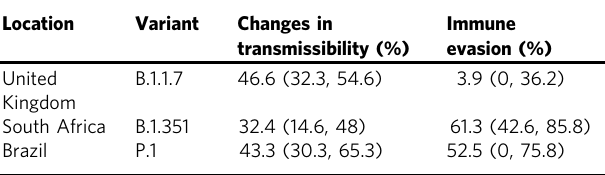
Numbers show model-estimated mean (95% CI) from 100 model-inference runs totaling 50,000 model mortality data combining multiple outbreak waves from different sub-regions of the country, and the lack of national restrictions to curb the pandemic. Despite this large fi rst pandemic wave, the emergence of the P.1 variant led to a second large pandemic wave from Dec 2020 onwards. Similar traveling waves through the country were evident from the incidence curve (Fig. 2e). By the week of 4/11/21, an additional 60.7% (95% CrI: 40.5 – 92.0%) of the population are estimated to have been infected, including re- infections. Estimated increased transmissibility and immune evasion .